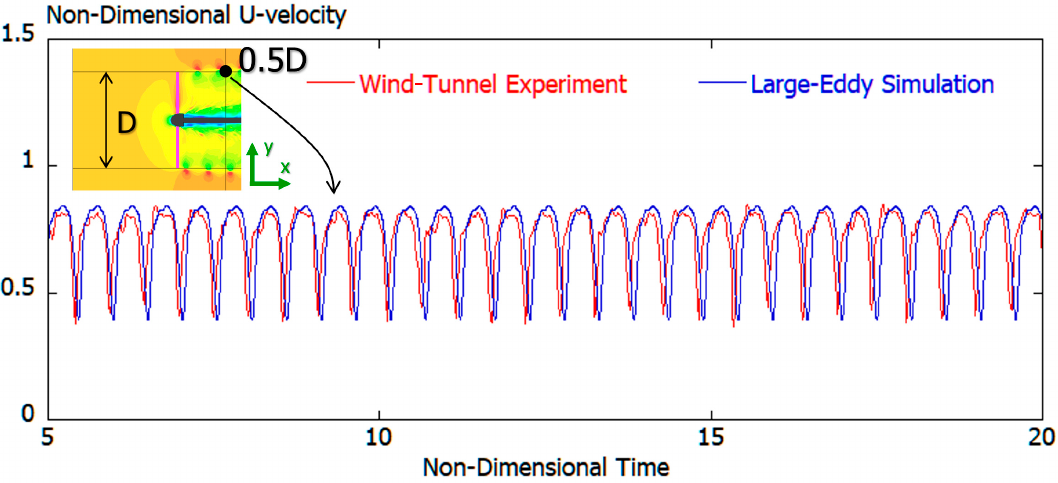
Figure 8. Comparison of time variation of instantaneous U-velocity at measurement points (x = 0.5 D and y = 0.5 D) indicated by symbols in Figure 6.